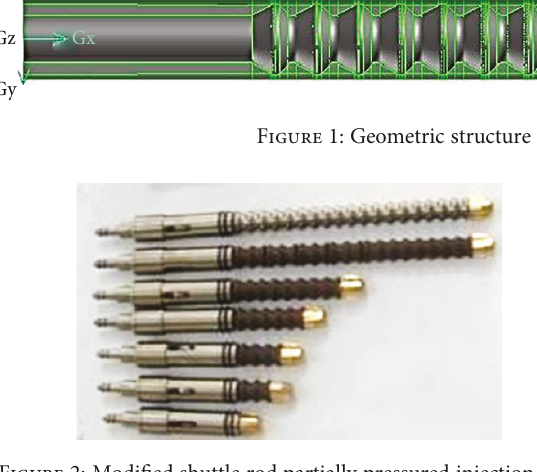
Figure 2: Modi fi ed shuttle rod partially pressured injection tool.